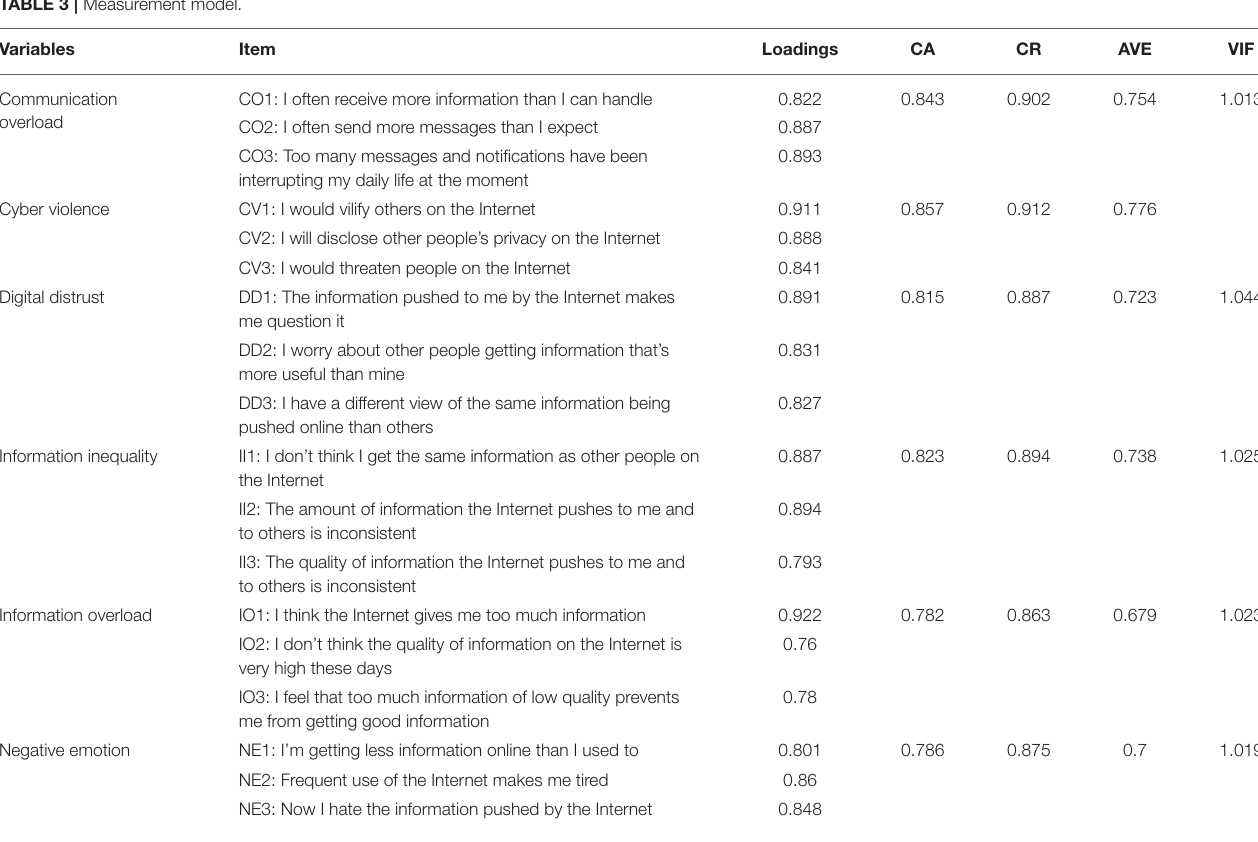
TABLE 3 | Measurement